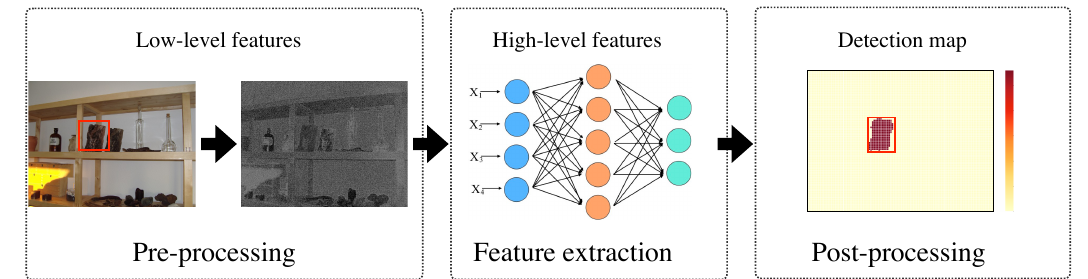
Figure 1. Generic framework for image tampering detection and localization, including image pre-processing, feature extraction, and